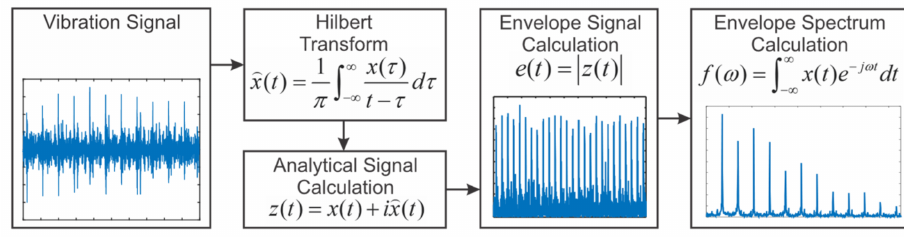
Figure 9. Envelope analysis